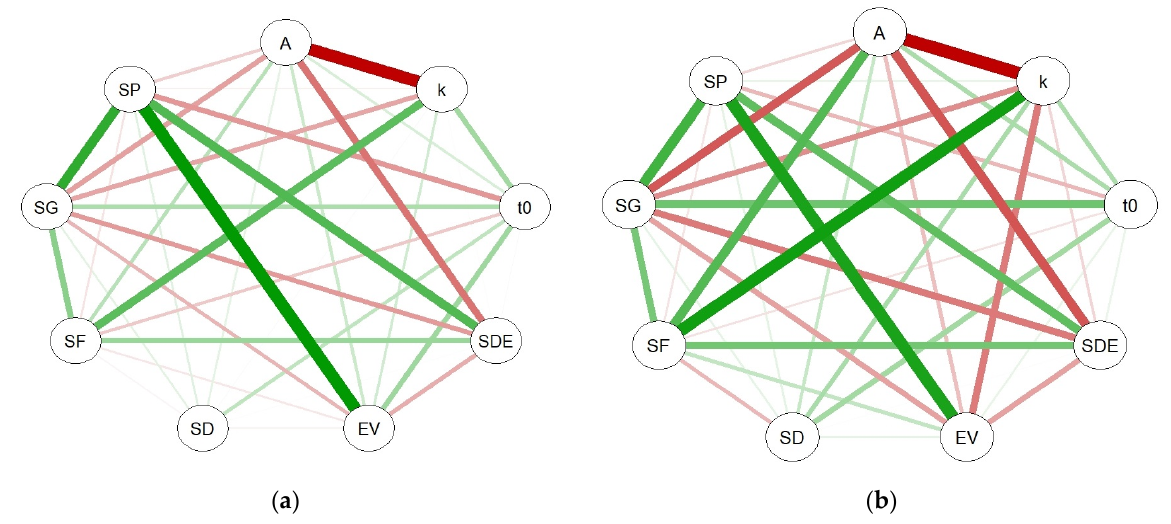
Figure 6. Partial correlation network between DBH–age growth curve parameters and topographic conditions ( a ) and height–age growth curve parameters and topographic conditions ( b ). The green and red lines indicate positive and negative correlations, respectively. The line thickness indicates the strength of the Spearman’s partial rank correlation. The letters in white circles indicate variables of tree growth parameters A , k , t 0 ; stand density (SDE) and topographic conditions elevation (EV), slope gradient (SG), slope direction (SD), slope form (SF) and slope position (SP).